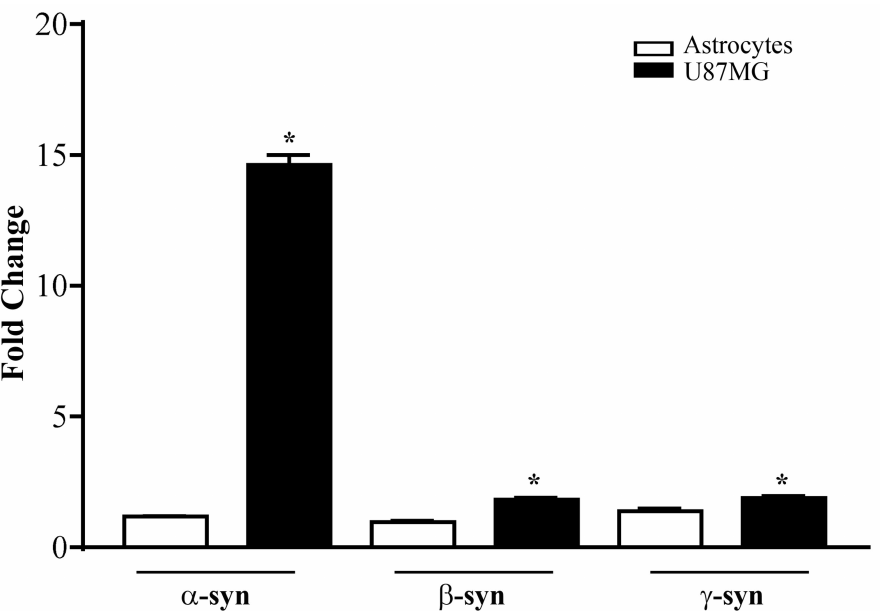
Figure 3. mRNA levels for α -syn, β -syn, and γ -syn in astrocytes and U87MG cells. α -Syn, β -syn, and γ -syn gene transcripts were assessed by quantitative RT-PCR analysis in astrocytes and U87MG cells in baseline conditions. Data are given as the mean ± SEM of n = 4 samples from N = 2 independent experiments, normalized with two different internal references, globin, and actin. * p < 0.05, compared with